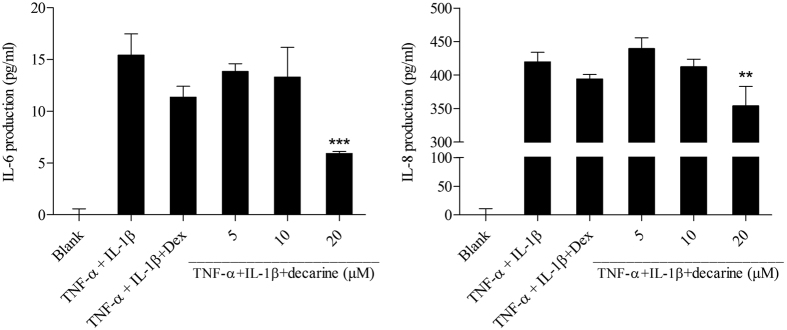
Effect of decarine on IL-6 and IL-8 production in IL-1β+TNF-α-induced Caco-2 cells.All values were means ± SD, n = 3. (*P < 0.05) *P < 0.05 indicated significant difference with cells treated by IL-1β and TNF-α. Dex: dexamethasone; IL-1β: interleukin-1β; TNF-α: tumor necrosis factor-alpha; IL-6: interleukin-6; IL-8: interleukin-8.